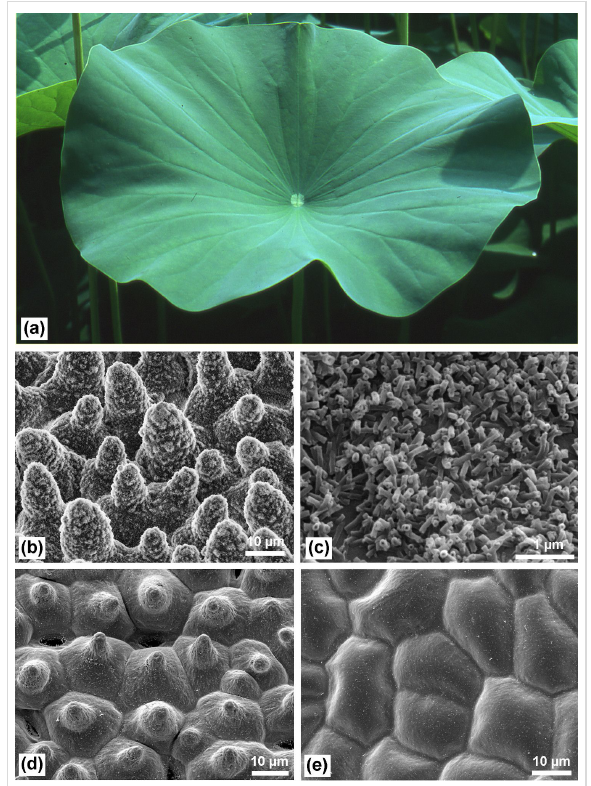
Figure 1: (a) Lotus leaves, which exhibit extraordinary water repel- lency on their upper side. (b) Scanning electron microscopy (SEM) image of the upper leaf side prepared by ‘glycerol substitution’ shows the hierarchical surface structure consisting of papillae, wax clusters and wax tubules. (c) Wax tubules on the upper leaf side. (d) Upper leaf side after critical-point (CP) drying. The wax tubules are dissolved, thus the stomata are more visible. Tilt angle 15°. (e) Leaf underside (CP dried) shows convex cells without